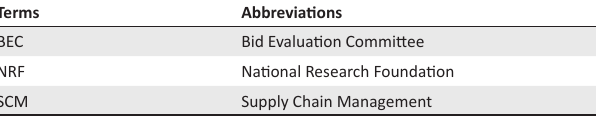
TABLE 1-A1: Terms and abbreviations used in the study Conceptual